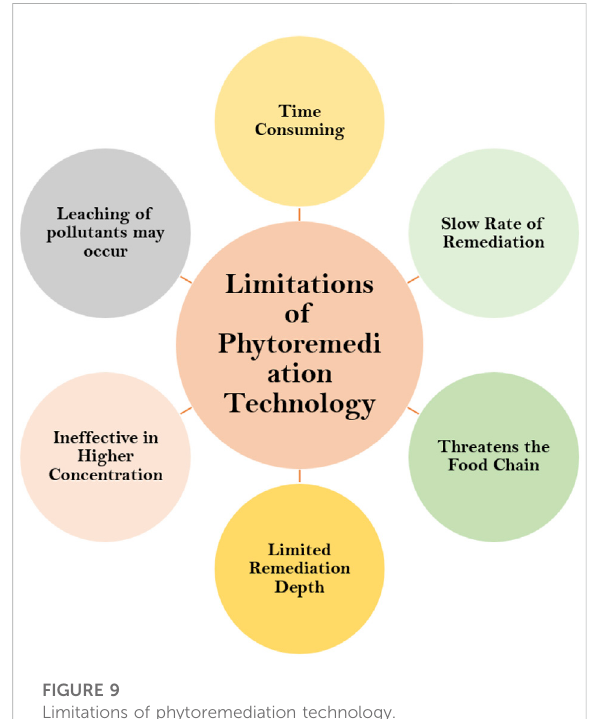
FIGURE 9 Limitations of phytoremediation